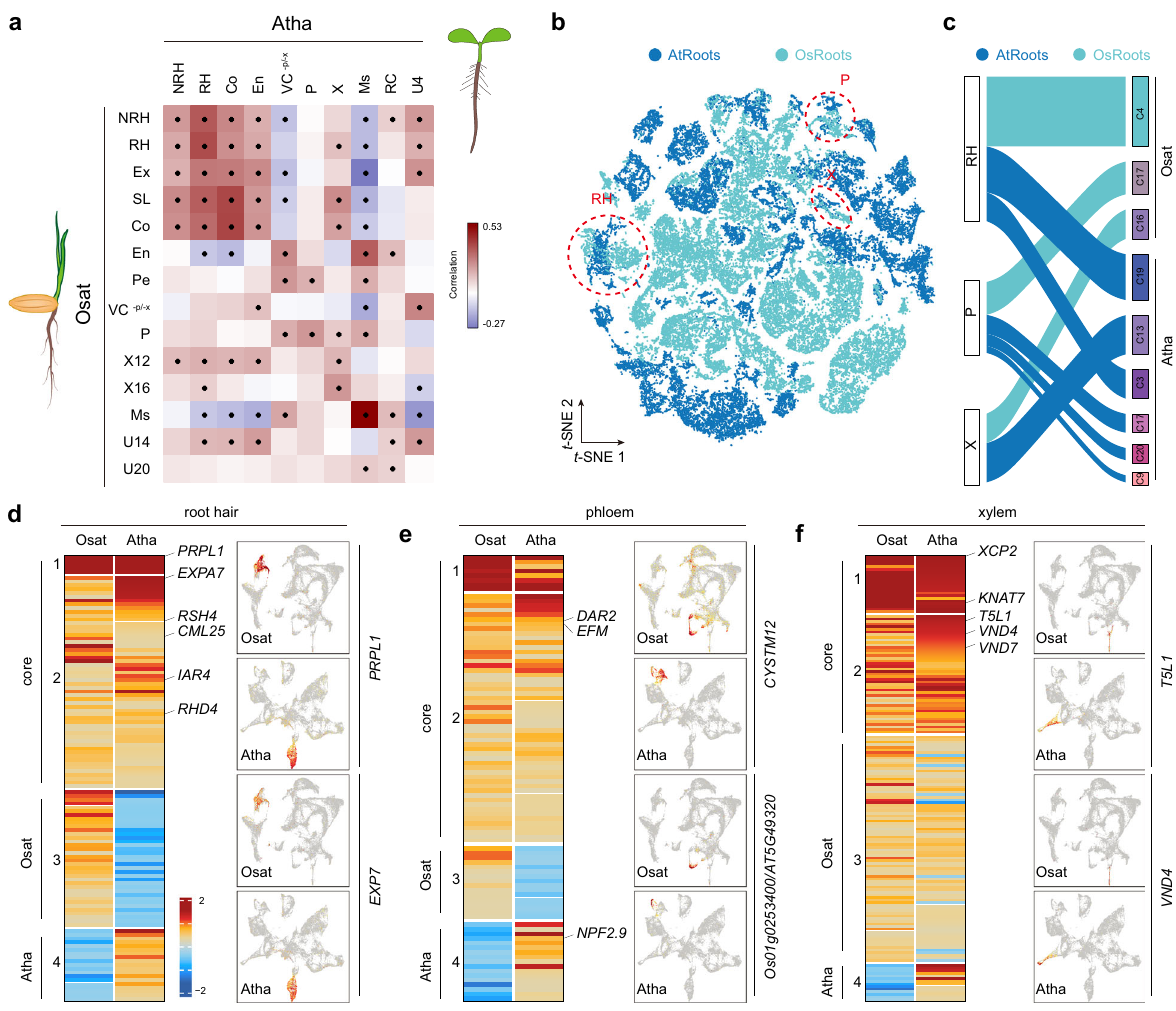
Fig. 5 Comparison of rice and Arabidopsis root tips at single-cell resolution. a Pairwise correlations of Arabidopsis (top) and rice (left) root cell clusters. Dots indicate statistically signi fi cant correlations. Atha, A. thaliana ; Osat, O. sativa ; NRH, non-root hair cells; RH, root hair; Ex, exodermis; SL, sclerenchyma layer; Co, cortex; En, endodermis; Pe, pericycle; VC -P-X , vascular tissue without phloem and xylem; P, phloem; X, xylem; X12 and X16, xylem clusters 12 and 16; Ms, meristematic cells; RC, root cap; U4, U14, and U20, unknown cell clusters 4, 14, and 20. b t -SNE plot showing 30 super cell clusters of Arabidopsis and rice root cells. Dotted circles mark the common RH, P, and X clusters, respectively. c Sankey diagram showing that Arabidopsis shares a high degree of similarities in RH, P, and X cell clusters with rice. Cluster number for Arabidopsis (Supplementary Fig. S7a) and rice (Fig. 1a) root cells is given on the right. d – f Gene clustering of RH ( d ), P ( e ), and X ( f ) clusters. For each cell type, core and species-speci fi c sub-gene clusters (labeled with Atha or Osat) were identi fi ed. The known genes expressed in root hair, phloem and xylem are indicated. The expression pattern of selected core genes for each cell type is plotted on UMAP (right). The full names of selected genes are given in Supplementary Data quality cell-type-speci fi c transcriptomes of the rice root tip, as has been done for Arabidopsis 54 – 56 .